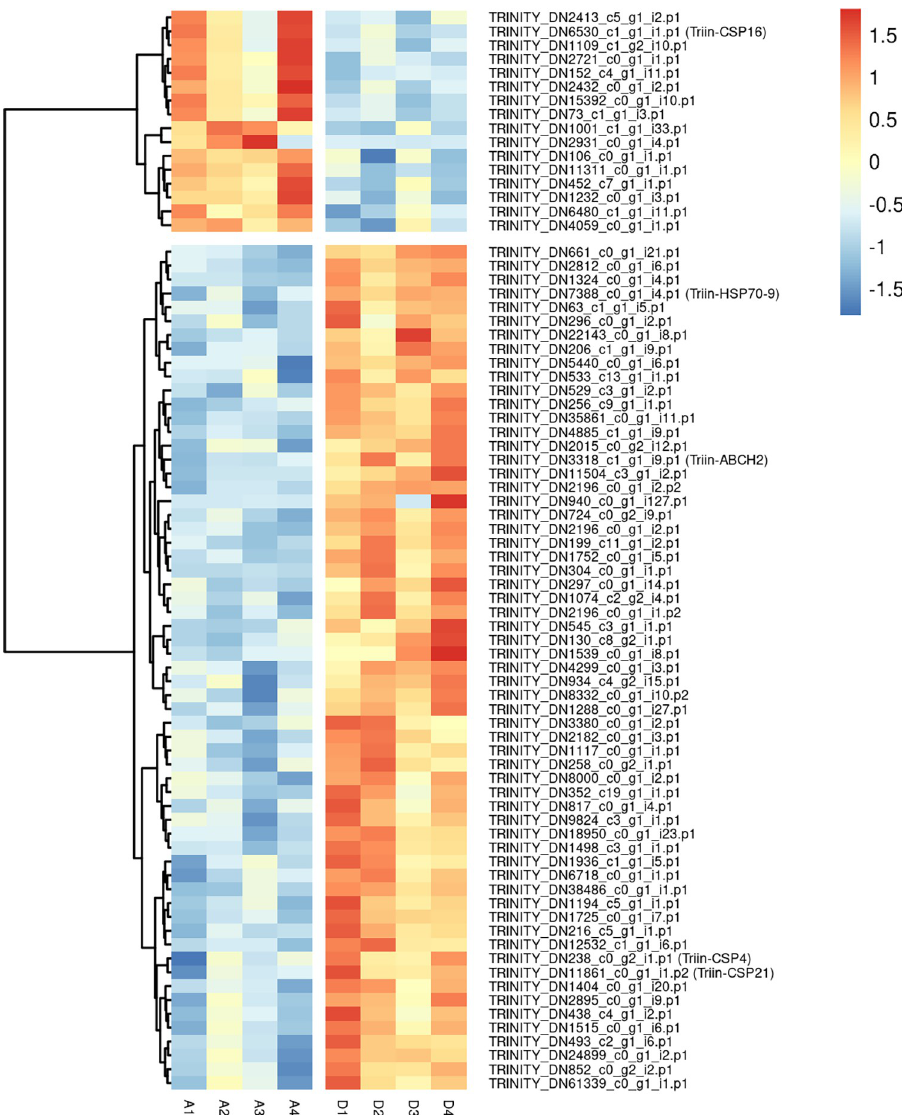
Fig 1. Effect of deltamethrin treatment on the transcription of differentially expressed genes identified in T . infestans . Heatmap was plotted using z-score calculated from the transformed count data, by means of a color scale in which blue/red represent lowest/highest expression. The dendrogram on the left represents the results of the row hierarchical clustering. A: Acetone (control) samples. D: Deltamethrin-treated samples.